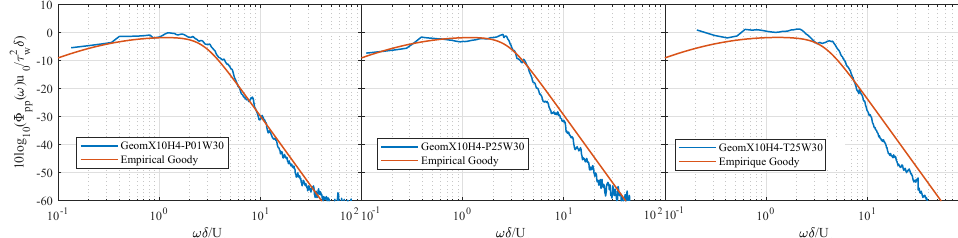
Figure 3. Wall pressure spectra (WPS) in the vicinity of the plate trailing edge (at 98% of the chord from the leading edge), for ( left ) GeomX10H4-P01W30 simulation, ( center ) GeomX10H4-P25W30 simulation, and ( right ) GeomX10H4-T25W30